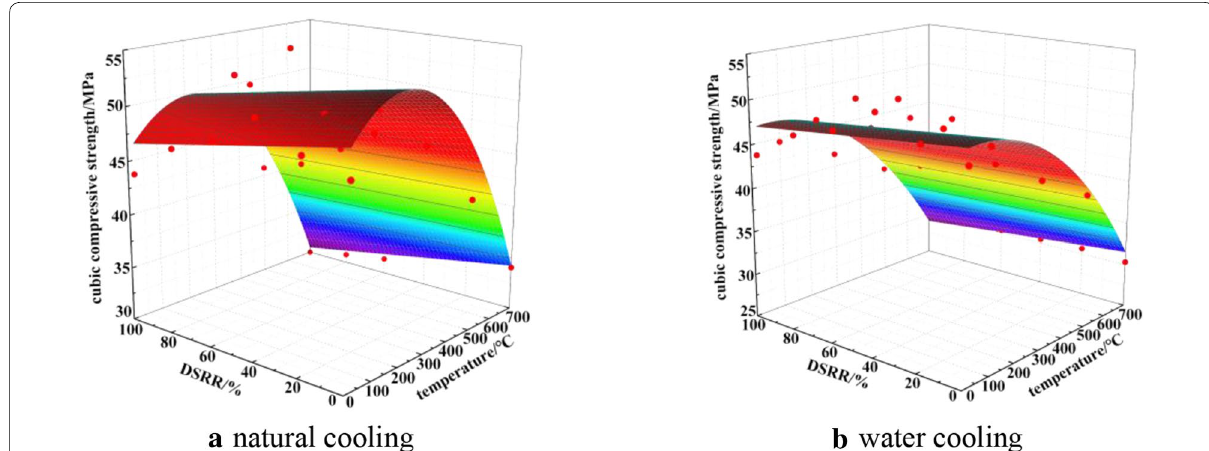
Fig. 6 Comparision of cubic compressive strength between the predicated results from the regression model and experimental results of concrete produced with desert sand.